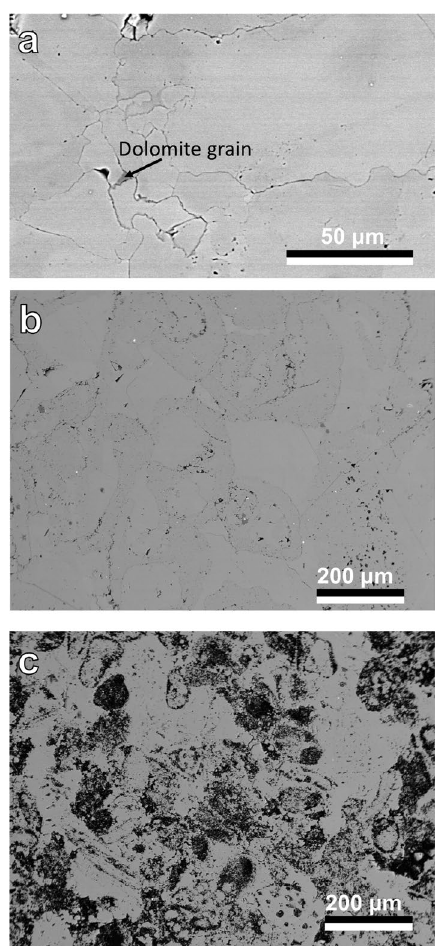
Figure 9. SEM-BSE image of ( a ) low porosity Carrara marble with highlighted dolomite grain, ( b ) low porosity limestone (Carthage marble) and ( c ) high porosity Texas Cream limestone. ( b ) and (c) reprinted from Weber et al. 5 , with permission from